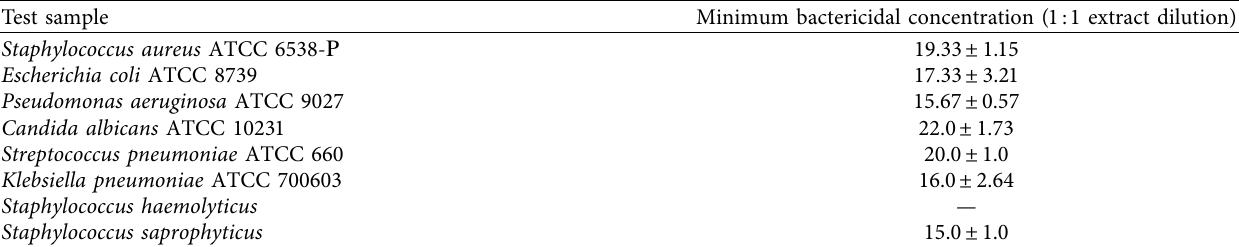
2 extraction) obtained by the disc diffusion method.